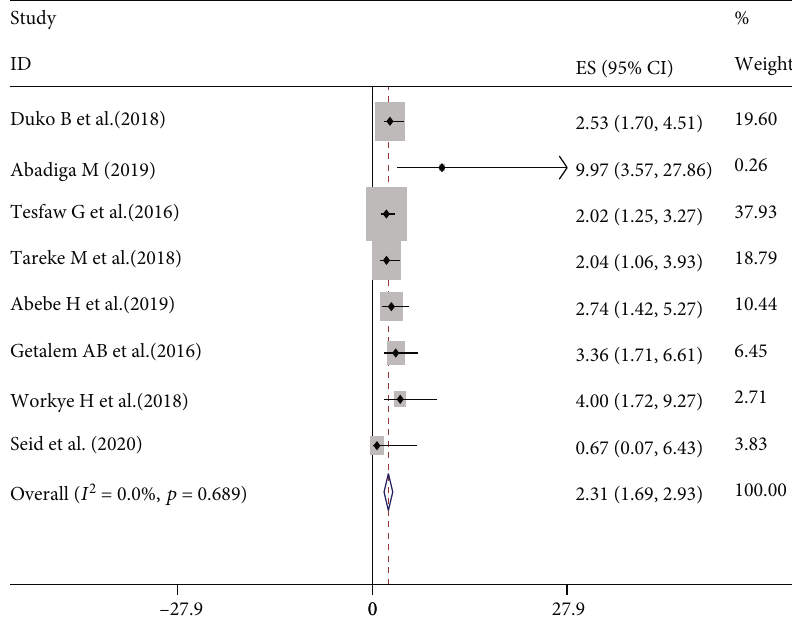
Figure 4: Forest plot of pooled OR between poor social support and depression among HIV/AIDS patients in Ethiopia.